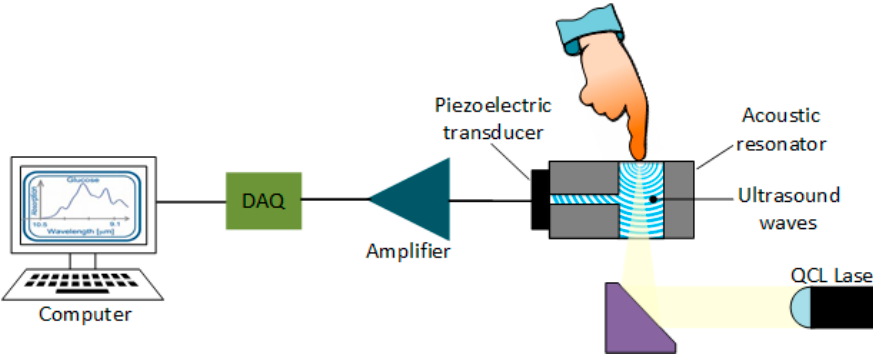
Figure 13. Basic optical setup for noninvasive photoacoustic measurement of glucose. Table 16. Advantages and disadvantages of photoacoustic spectroscopy.